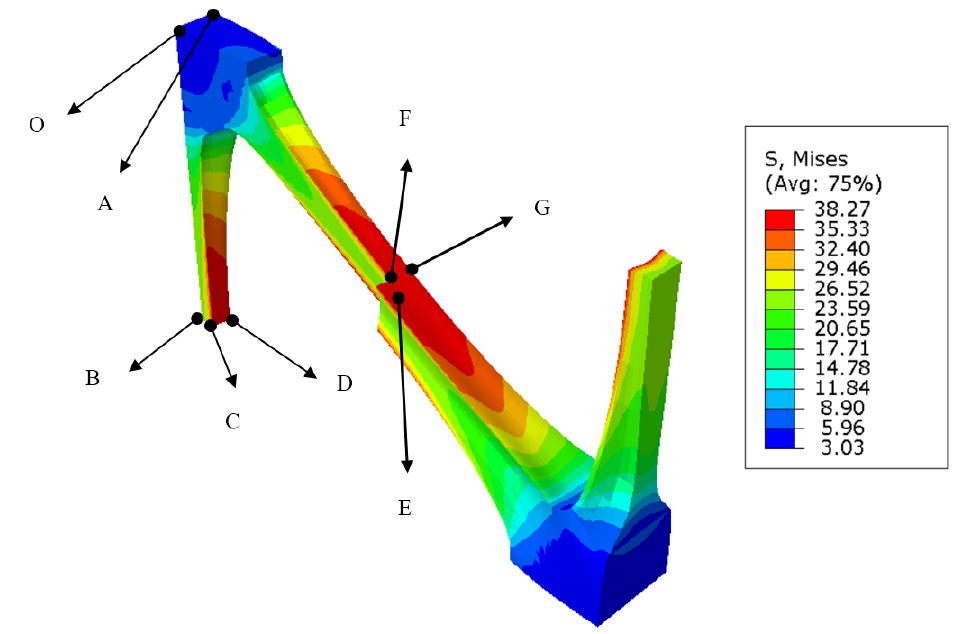
Figure 22. Stress-strain point